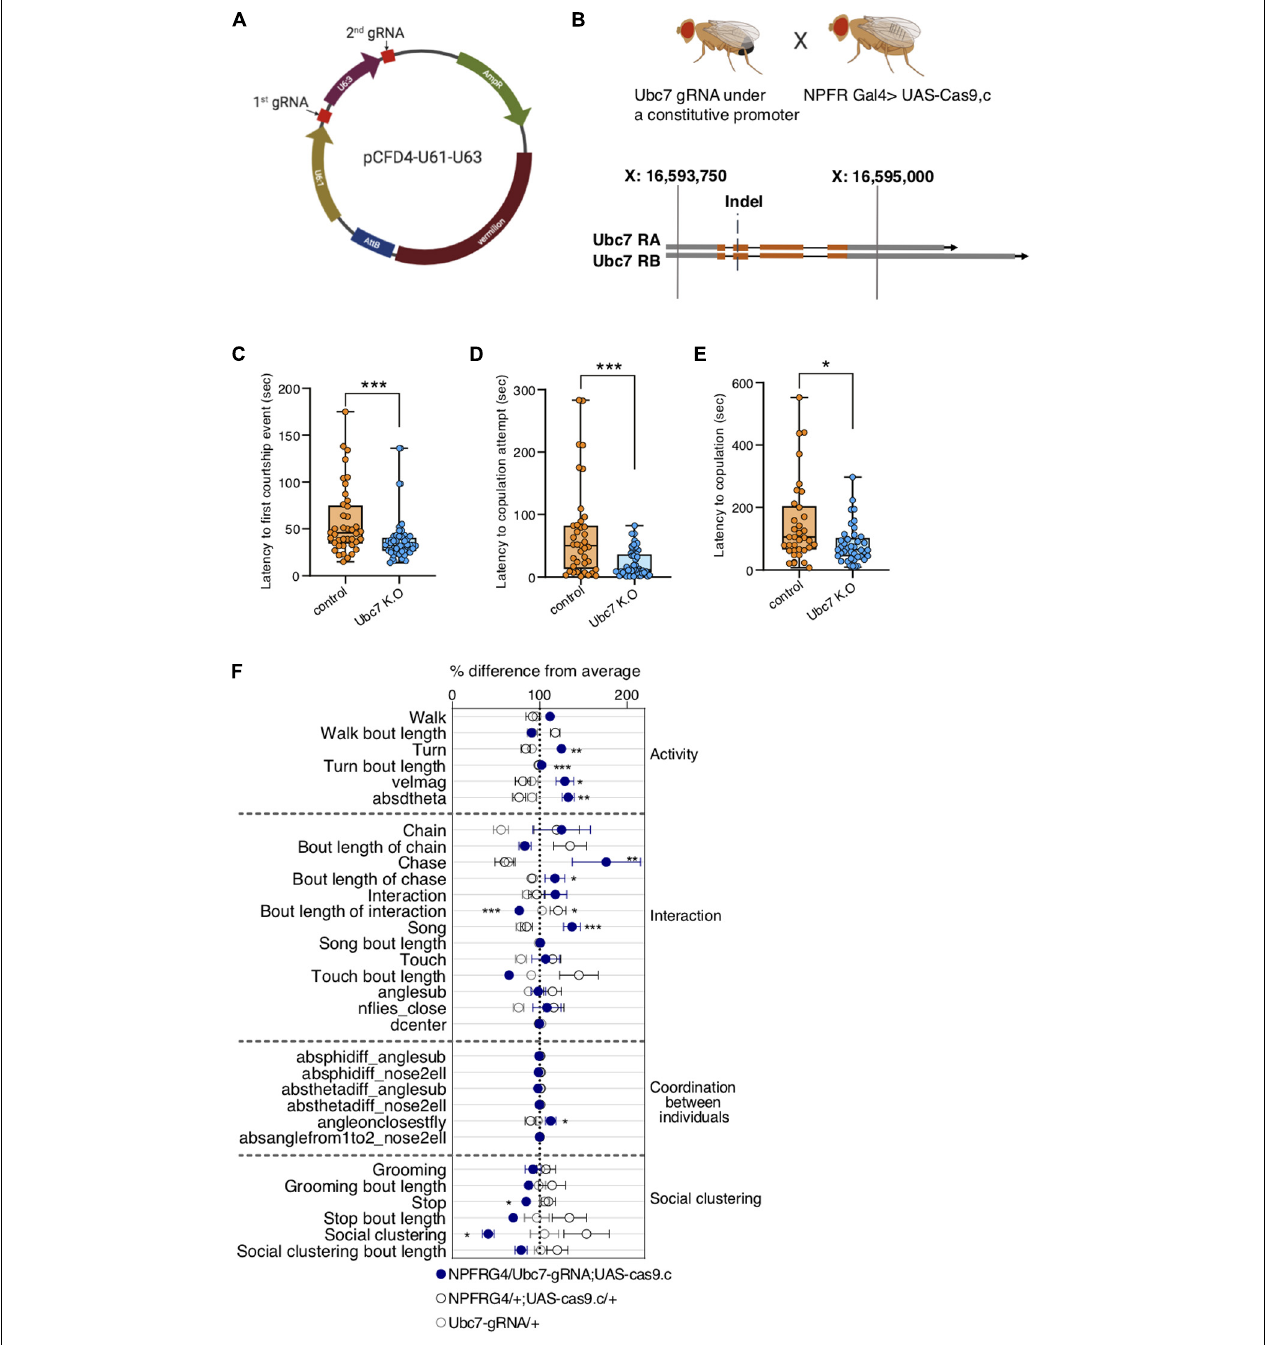
FIGURE 6 | Tissue specific K.O of Ubc7 elevates the motivation to court and enhances male-male social interaction. (A) Representation of pCDF4 plasmid containing two gRNAs (red). (B) Crossing scheme of flies containing gRNAs with NPFR-Gal4; Cas9.c flies to generate tissue specific Ubc7 K.O flies (upper panel). Lower panel depicts two Ubc7 isoforms (orange and gray blocks representing coding and non-coding exons, respectively, Black lines representing introns). The double strand break occurred at the beginning of the 2nd coding exon. (C–E) Male flies containing NPFR-Gal4/Ubc7-gRNA; UAS-Cas9.c/ + (blue) were introduced to naïve females in courtship arenas and were video recorded, their courtship behavior was analyzed for latency to first courtship event (C) , latency to first copulation attempt (D) and latency to copulation (E) compared to genetic controls (NPFRG4/attp1;UAScas9.c, orange). n = 47 and 40 in (C) , n = 46 and 39 in (D) , n = 39 and 33 in (E) for experimental and control groups, respectively. Mann-Whitney test. * P < 0.05, *** P < 0.001. (F) Behavioral signatures of social group interaction in male flies harboring NPFR-Gal4/Ubc7-gRNA; UAS-Cas9.c/+ (blue) compared to NPFR-Gal4/+; UAS-Cas9.c/+ and Ubc7 gRNA/+ (gray and black, respectively). Data is presented as normalized scatter plots depicting % difference from average of 31 behavioral features. n = 8, 5, and 11, respectively. One-way ANOVA with Tukey’s post hoc for normally distributed parameters and Kruskal-Wallis with Dunn’s test post hoc for non-normally distributed parameters. FDR correction was performed for all features. * P < 0.05, ** P < 0.01, *** P < 0.0001, n . s . P > 0.05.